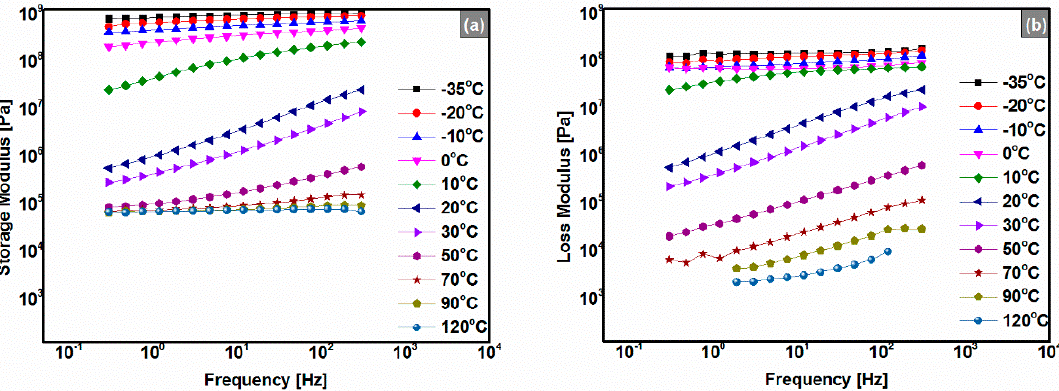
Figure 5. Frequency sweep results of the 180#; ( a ) storage modulus (| G ’|) vs. frequency; ( b ) loss modulus (| G ’’|) vs. frequency. All the anhydrides-cured bimodal REACs behaved similarly.